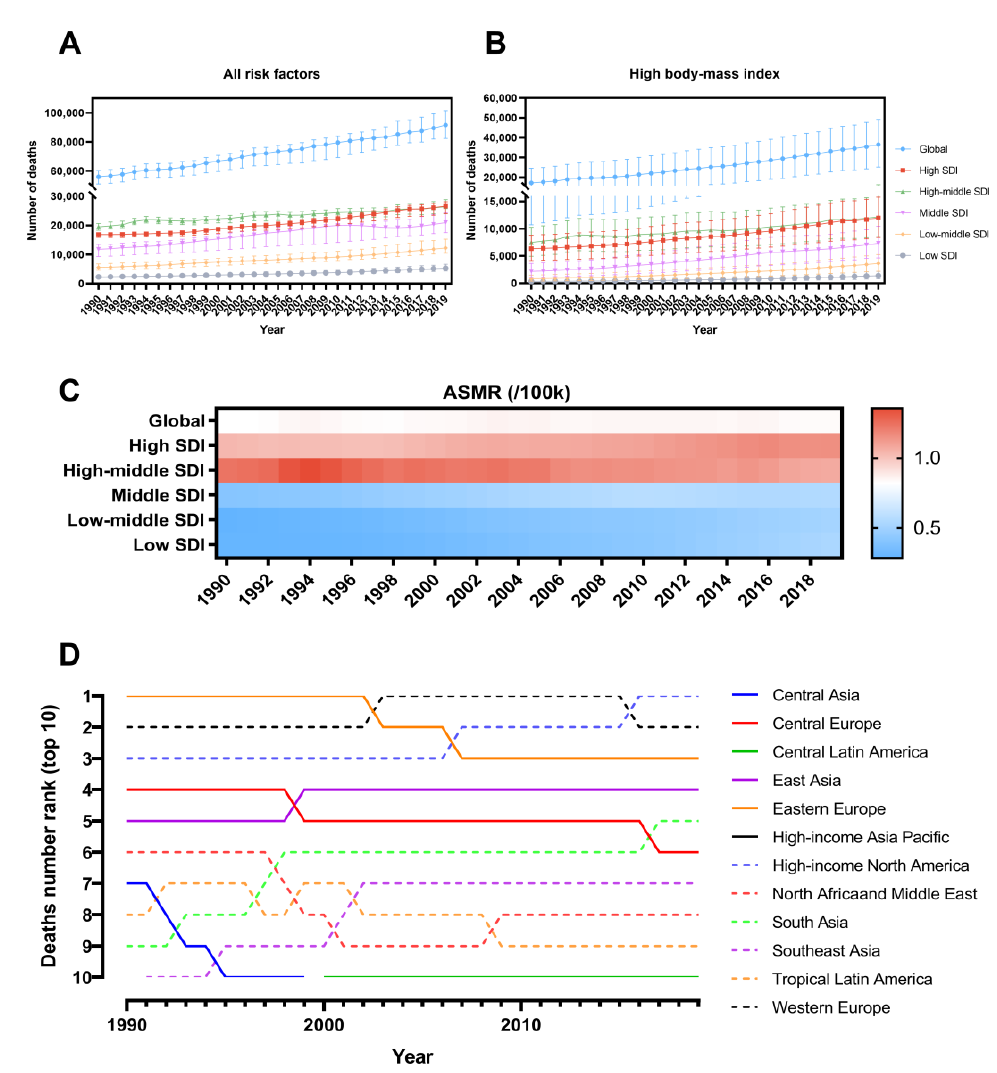
Figure 1. ( A ) Number of uterine cancer deaths under all risk factors from 1990 to 2019. ( B ) Number of uterine cancer deaths attributable to high BMI. ( C ) ASMR from 1990 to 2019 for global and SDI regions. ( D ) Ranking of uterine cancer deaths attributable to high BMI in GBD regions, 1990–2019 (Top 10). BMI, Body mass index; ASMR, Age-standardized mortality rate; SDI, Socio-demographic Index; GBD, Global Burden of Disease Study.